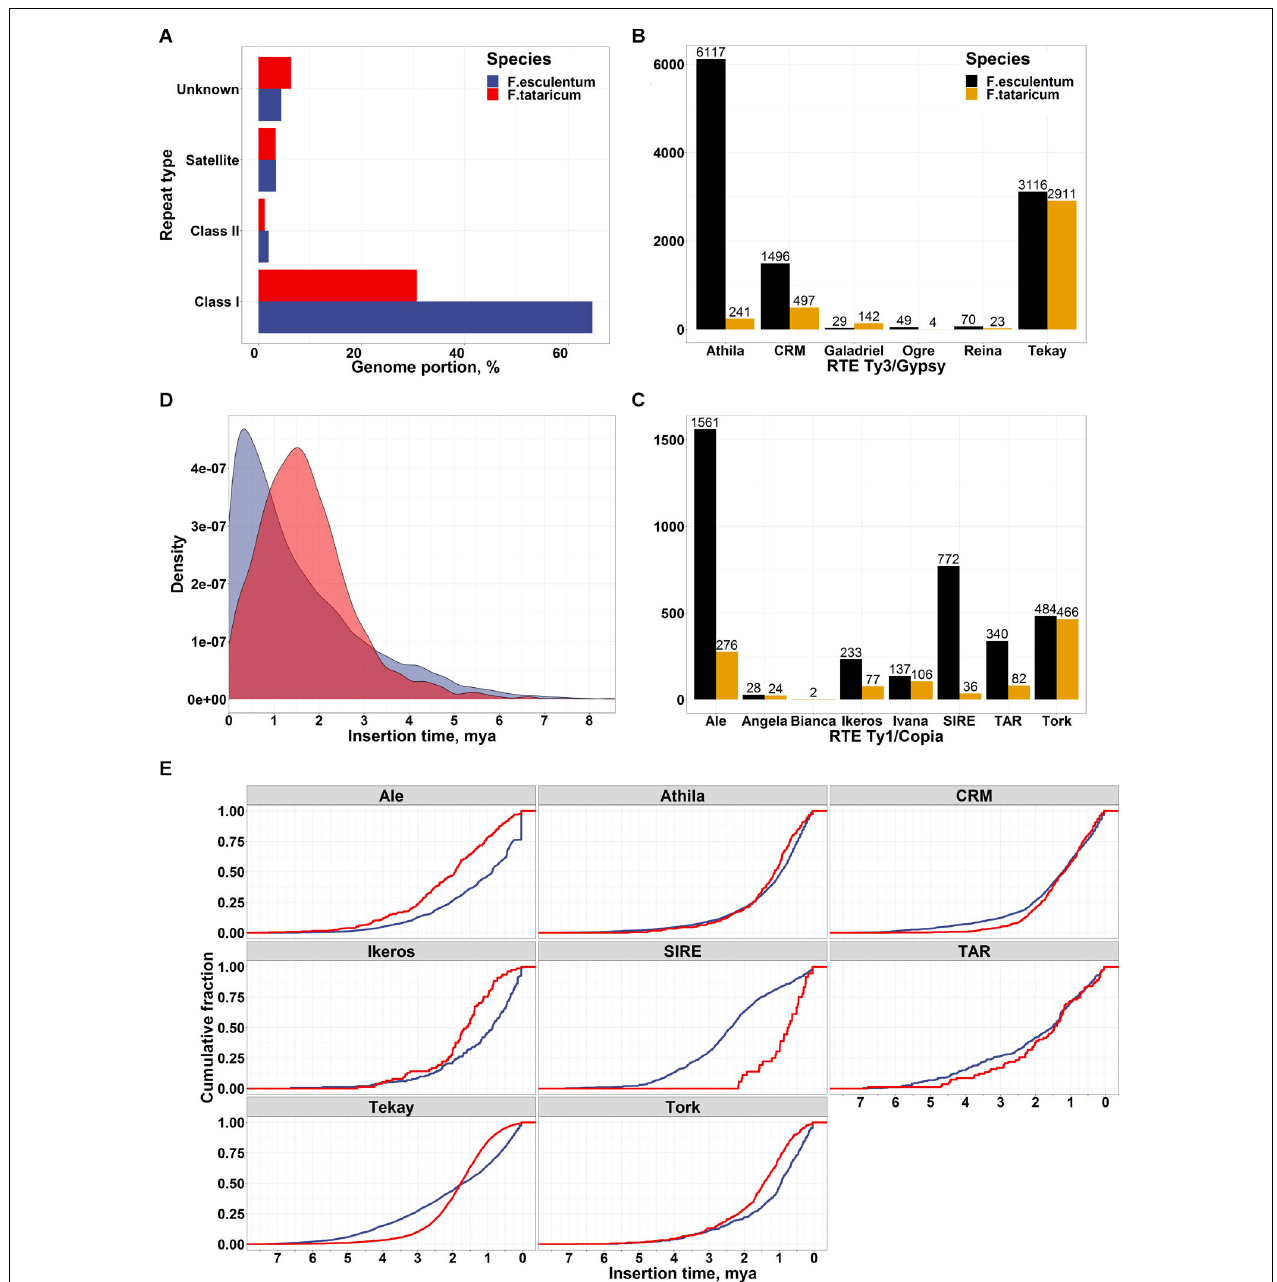
FIGURE 2 | (A) Comparison of genome abundance of different types of repeats in the F. esculentum and F. tataricum genomes based on the RepeatExplorer (Novak et al., 2013) clustering of NGS genomic reads. (B,C) Number of full-length Ty3/Gypsy and Ty1/Copia LTR RTEs of different families based on prediction in the assembled genome sequences. (D) Insertion time comparison for F. esculentum (blue) and F. tataricum (red) LTR RTEs. (E) Cumulative plot of the insertion time for RTE